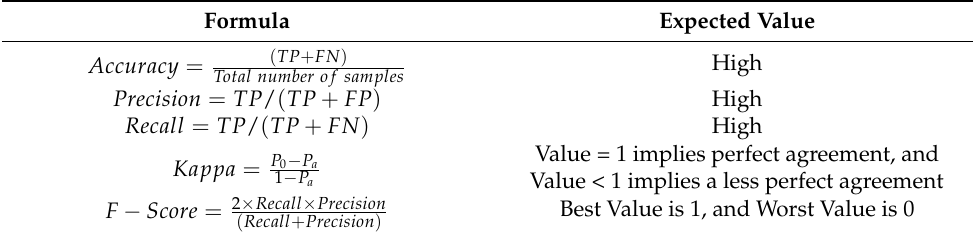
Table 3. Evaluation metrics of classification